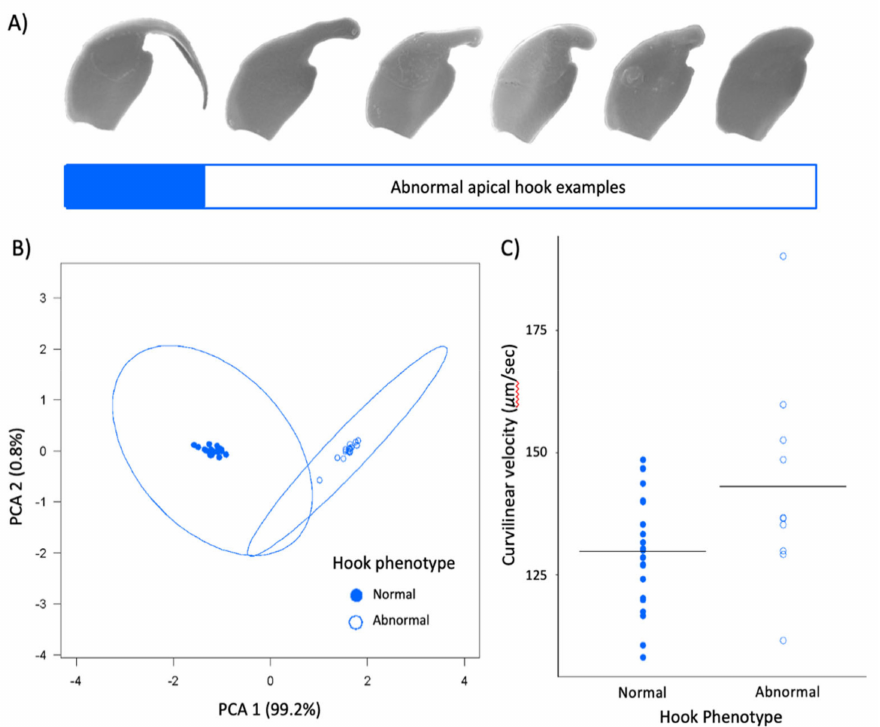
Figure 5. Apical hook variation in P. leucopus colony. ( A ) Example scanning electron micrographs of sperm with normal hooks (solid blue) and range of abnormal hook phenotypes (white). ( B ) When hook length and area are reduced to principal components, two discrete categories of males are formed based. Dots denote individual males, circles represent 95% confidence intervals. ( C ) Sperm with normal hooks (blue) are slower than those with abnormal hooks (white). Circles represent mean value for each male, and black lines represent group mean. Note truncated